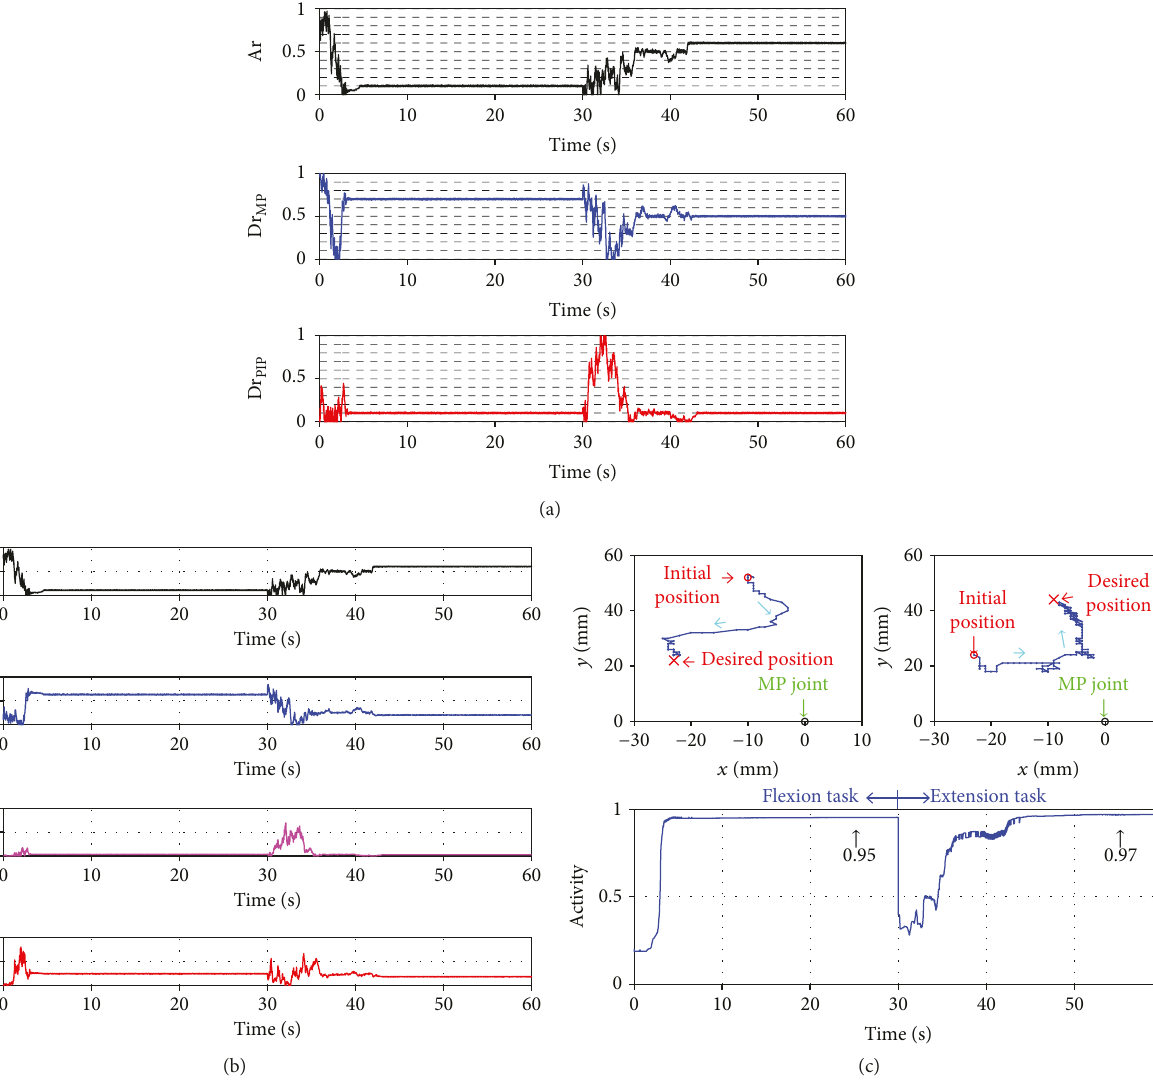
Dr MPf , and PIPf ) and the